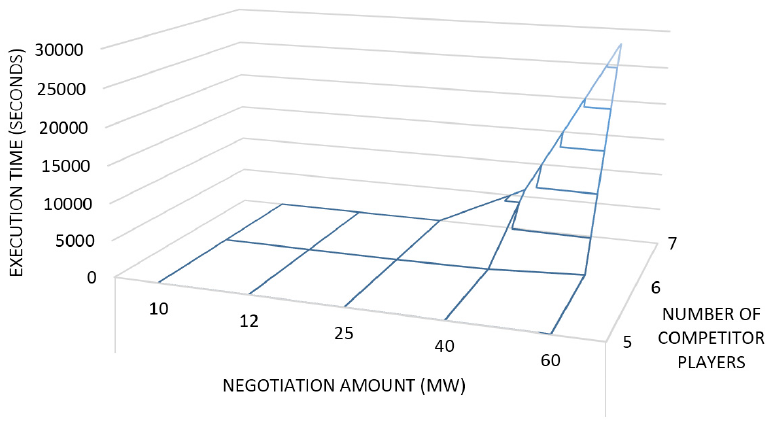
Figure 7. Execution time of the proposed